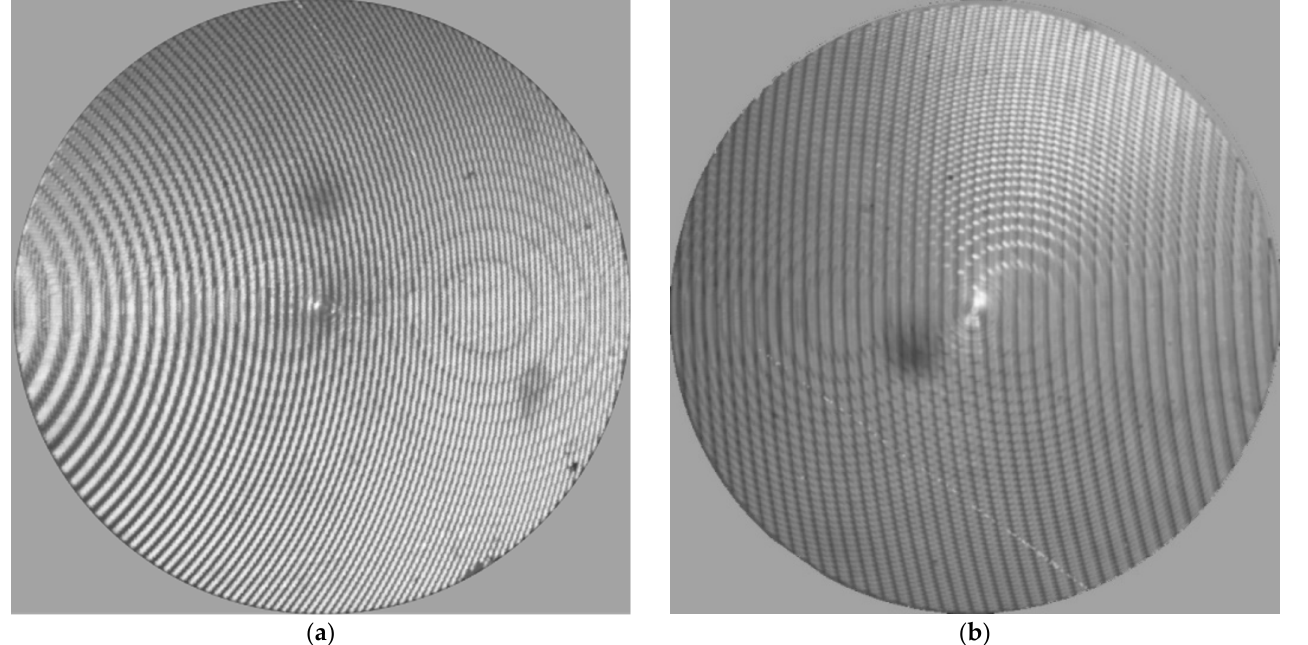
Figure 7. Fabricated MWDLs focusing the wavelengths λ 1 = 455 nm, λ 2 = 750 nm ( a ) and λ 1 = 900 nm, λ 2 = 970 nm ( b ) to two